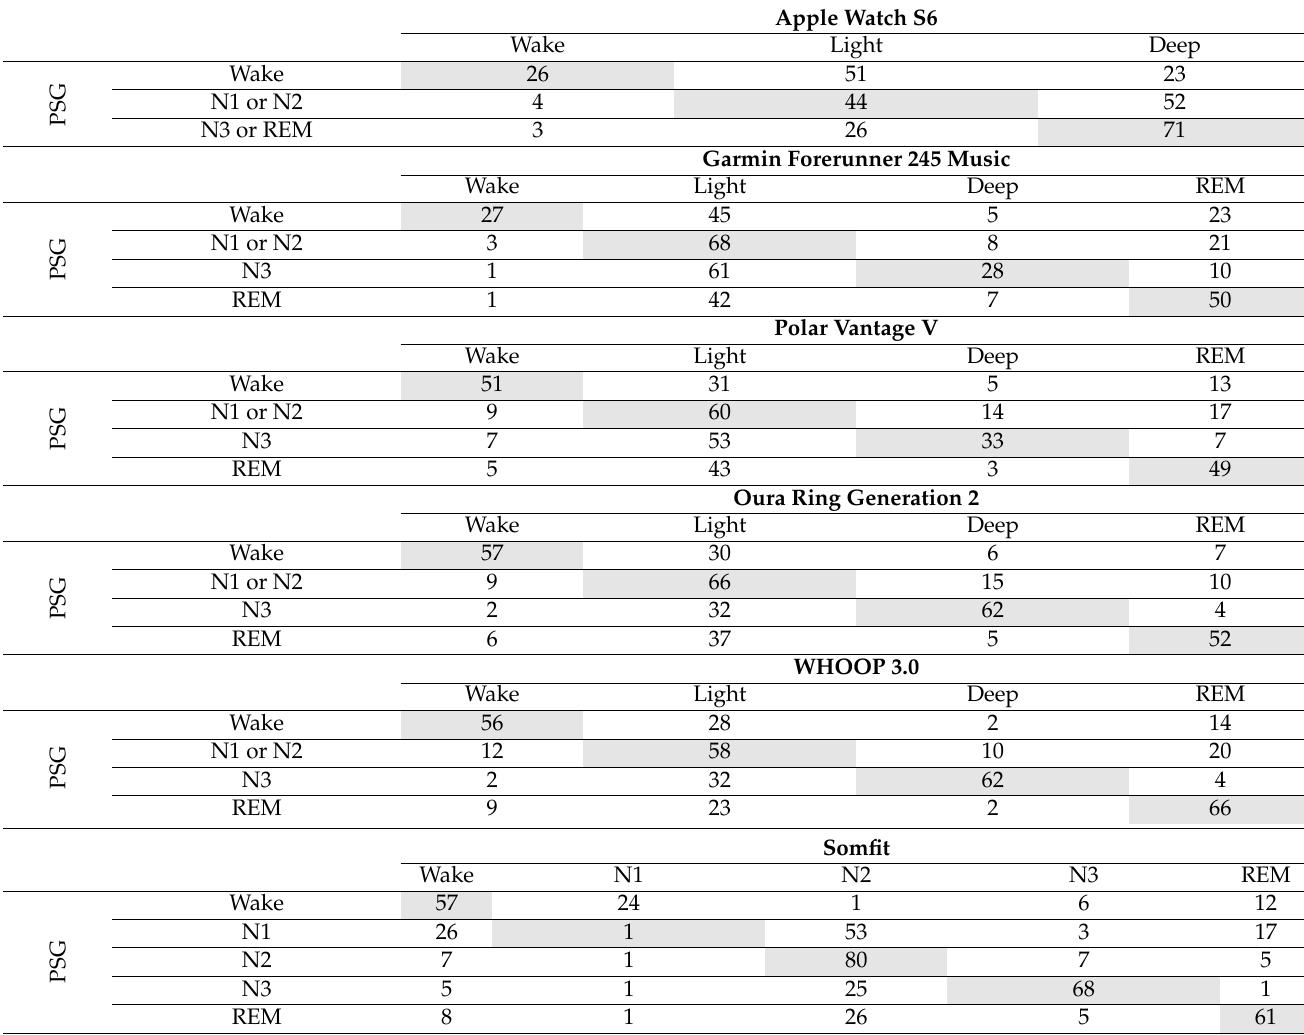
Table 5. Error matrices for classification of sleep state for each device against PSG (%).